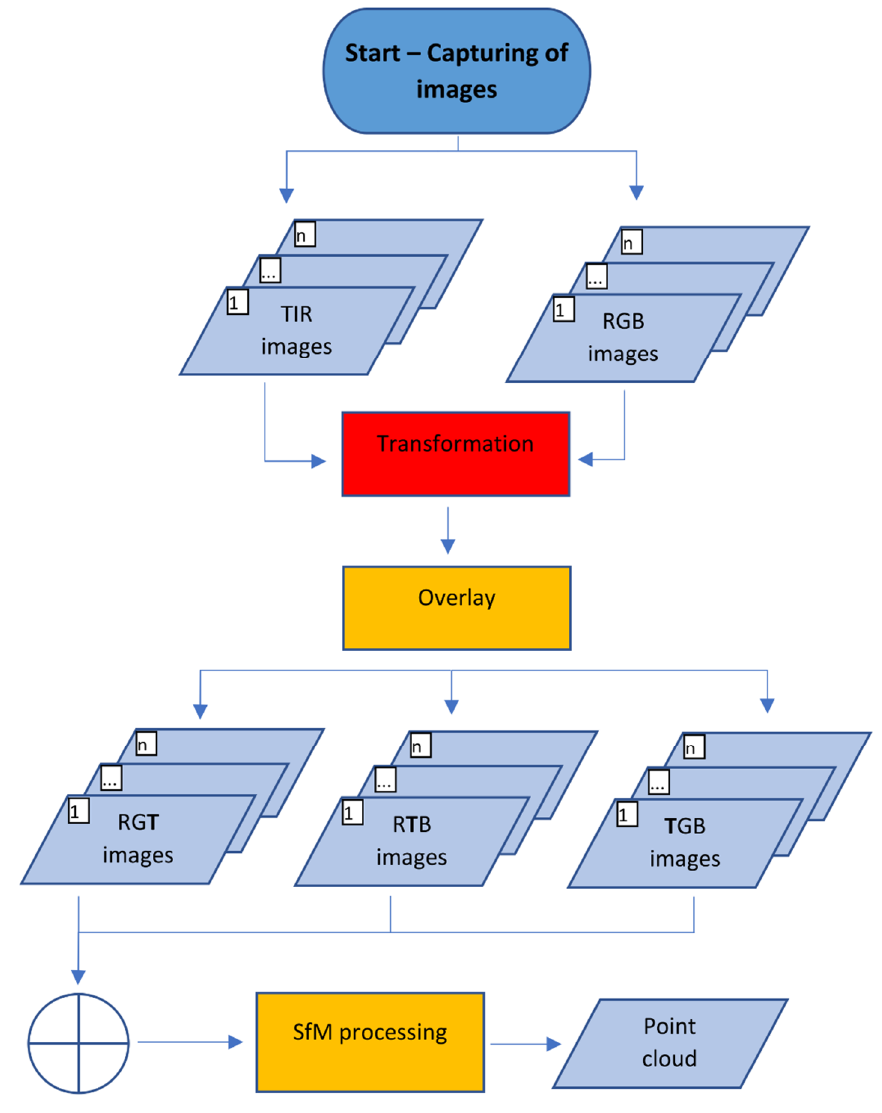
Figure 2. Diagram of the Sharpening method.